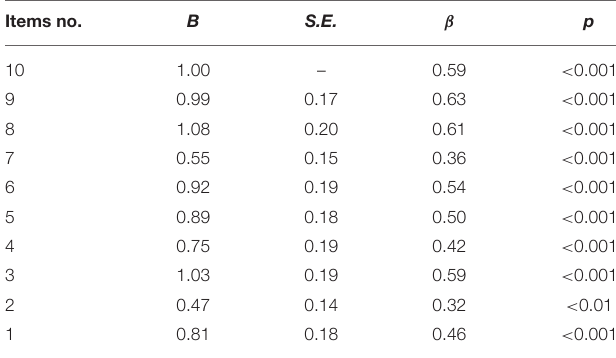
TABLE 4 | Factor loading of confirmatory factor analysis (CFA) for the Urdu MSI-BPD in individuals with cardiac problems ( N = 150). Items